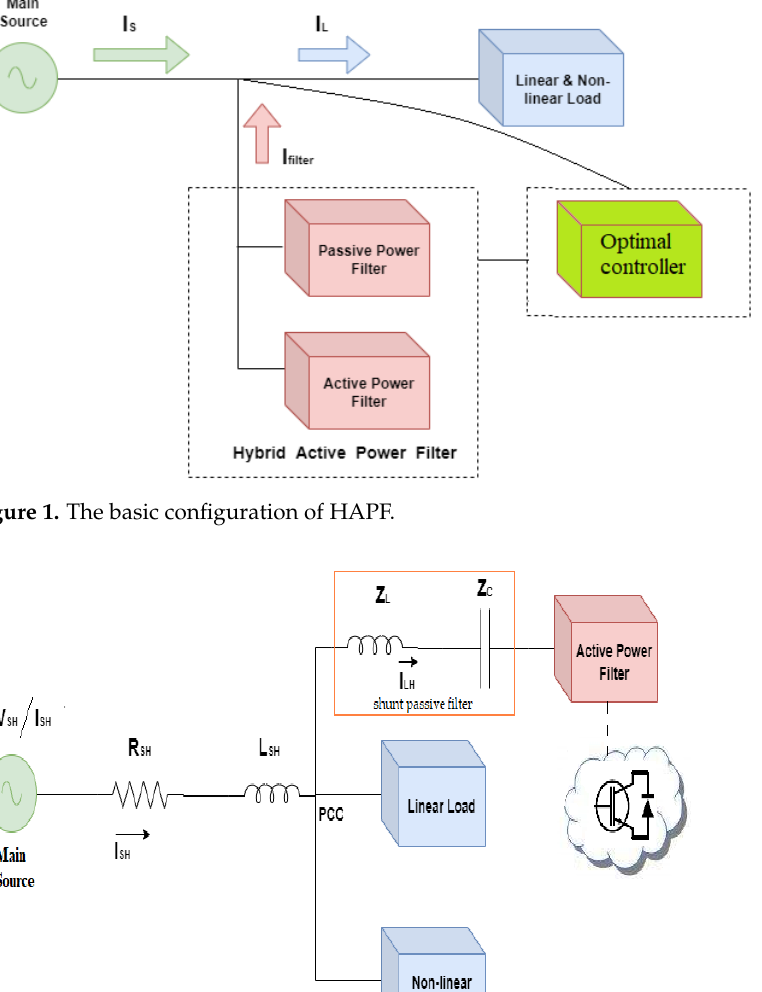
Figure 1. The basic configuration of HAPF.